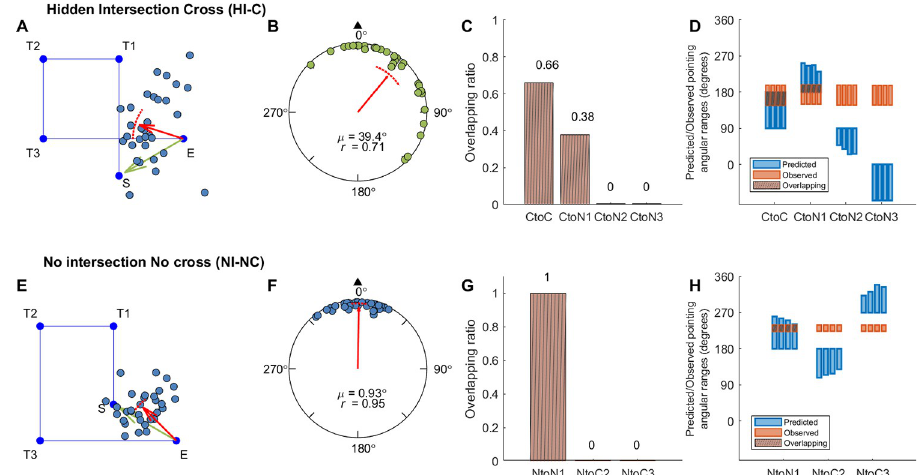
Fig 9. Response pointing directions and hypothesis comparison results in Experiment 2 (HI-C and NI-NC conditions). Panel A, E: Example pointing directions in one path (A: Path 4; E: Path 8). The red arrow indicates the circular mean direction and the distance of the pointing across all participants. Panel B, F: Mean pointing error (AE G ) across paths for each condition. Panel C, G: Mean overlapping ratio between observed and predicted pointing ranges across paths for each hypothesis (Fig 7, S2 Table). Panel D, H: Predicted or observed pointing angular ranges (in degrees) for individual paths. Abbreviations and legend are the same as in Fig 3.